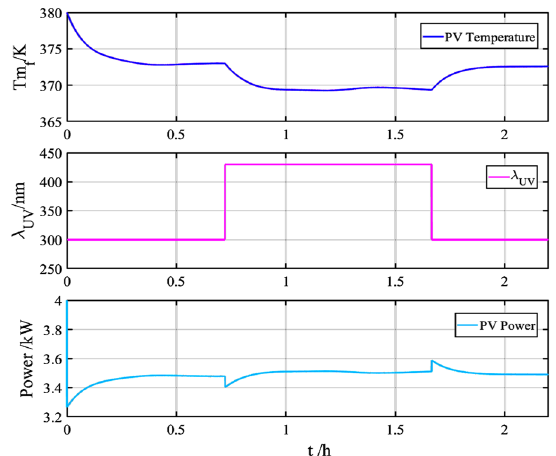
Fig. 5 Structure block diagram of MPC